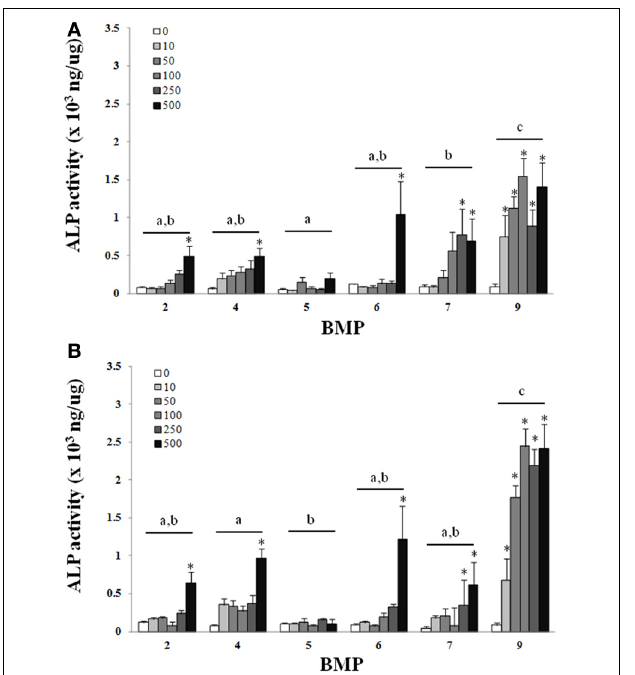
FIGURE 1 | C 2 C 12 cells were treated with BMP-2,- 4,-5, -6, -7, or -9 for 3 days and lysed on day 3 (A) or 7 (B) after the initiation of treatment. Error bars are ± SEM. Different letters signify a difference among groups, p ≤ 0 . 05. ∗ Significantly different control (0ng/ml BMP) within group, p ≤ 0 . 05.